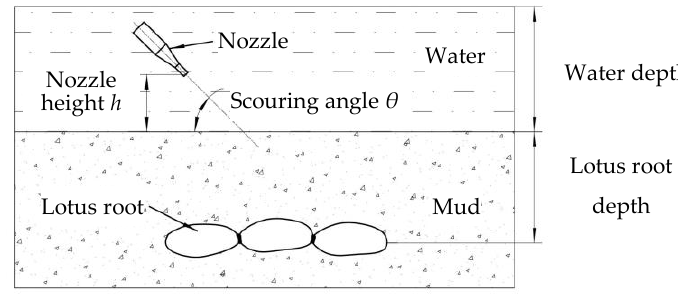
Figure 11. The nozzle flushing diagram. Table 8. Single-factor test plan and results.